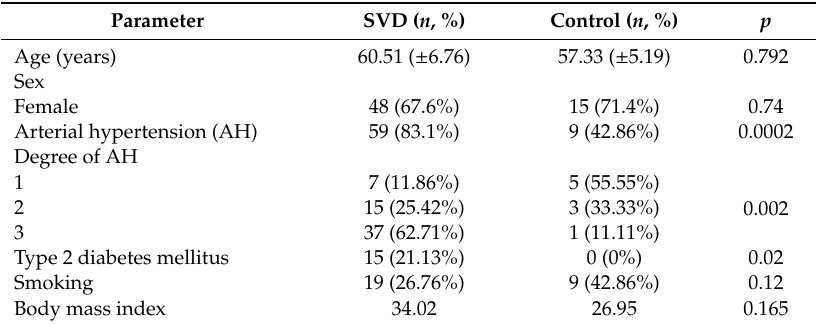
Table 2. Clinical symptoms in patients with SVD.